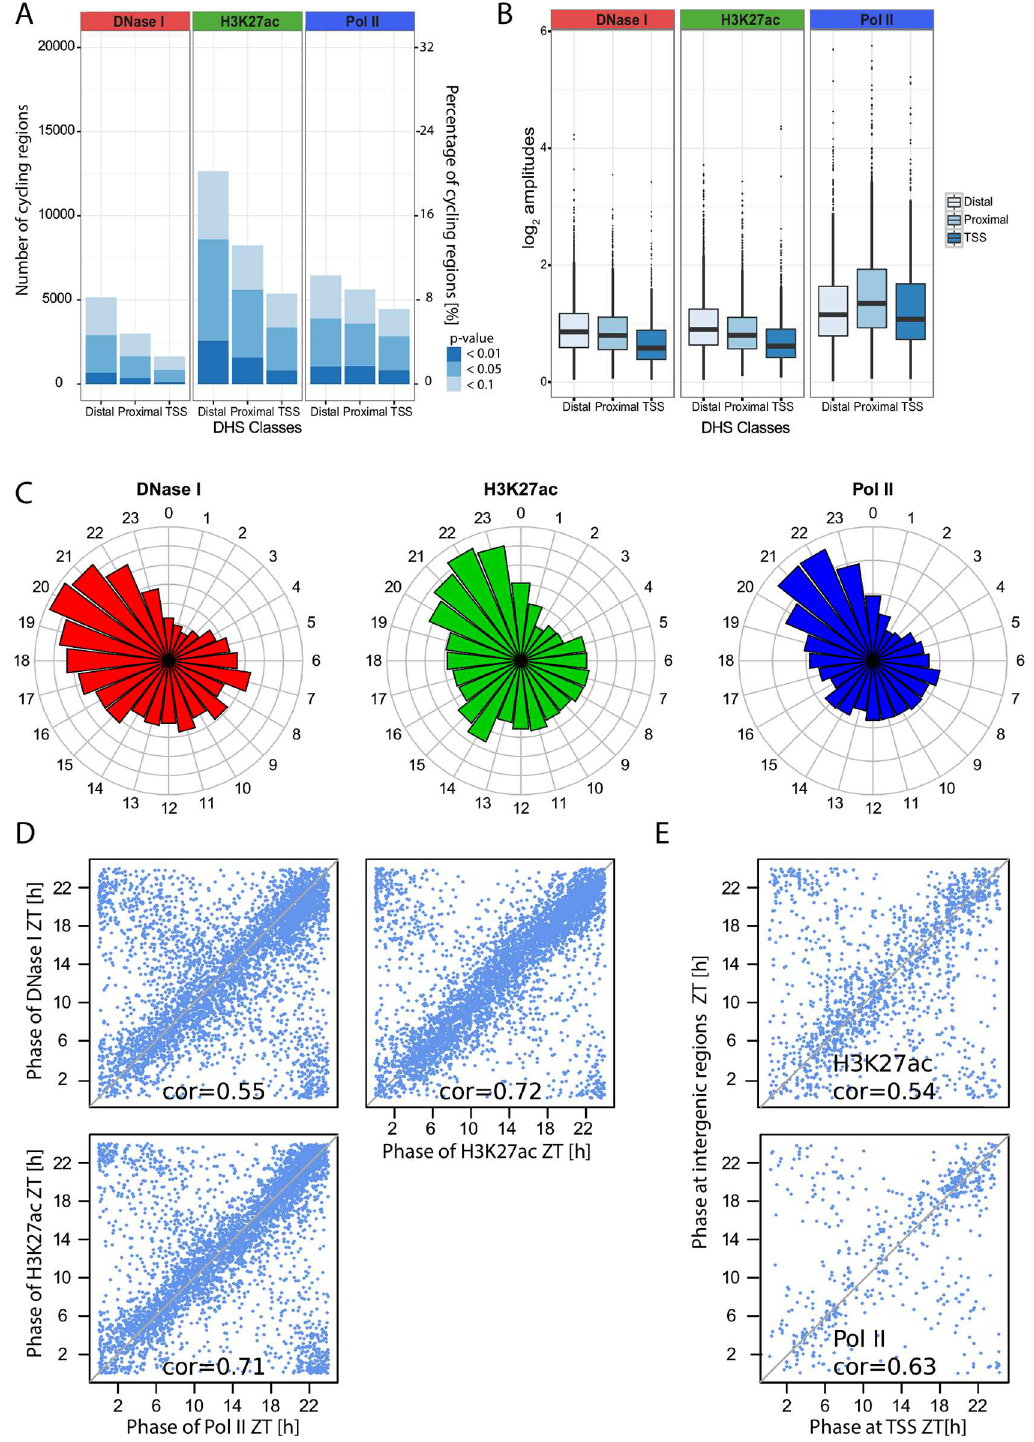
Fig 3. Genome-wide rhythms in DNase I signals are synchronous with RNA Polymerase II (Pol II) transcription and histone acetylation. A. Number of DNase I hypersensitive sites (DHSs) with statistically significantcycling DNase I signals (left), H3K27acsignals (middle), or Pol II signals(right) at three different thresholds ( p < 0.1, p < 0.05 and p < 0.01, harmonic regression),partitioned accordingto their genomiclocation:TSS (1 kb), proximal(1–10 kb from TSS), or distal ( > 10kb from TSS). B. Comparisonof log 2 amplitudesfor DHSs in each class (TSS, proximal, and